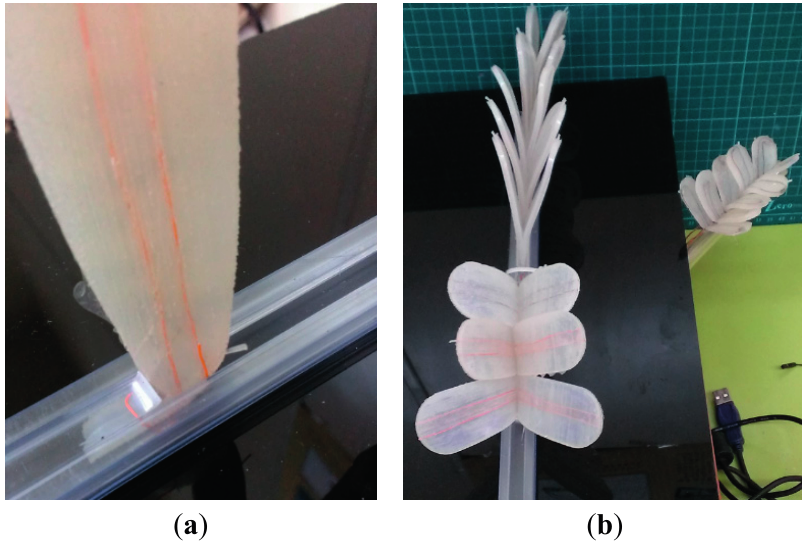
Figure 11. Appearance of strain prototype: ( a ) a single leaf implanted in a plastic cylindrical case; ( b ) numerous pairs of leaves implanted in the prototype.